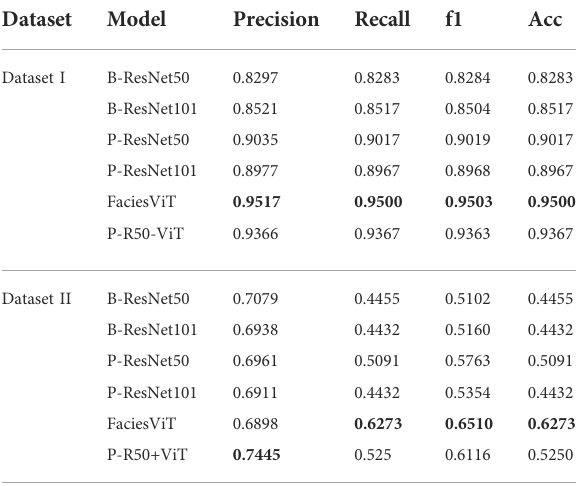
TABLE 6 Summary of results. The best results are presented in